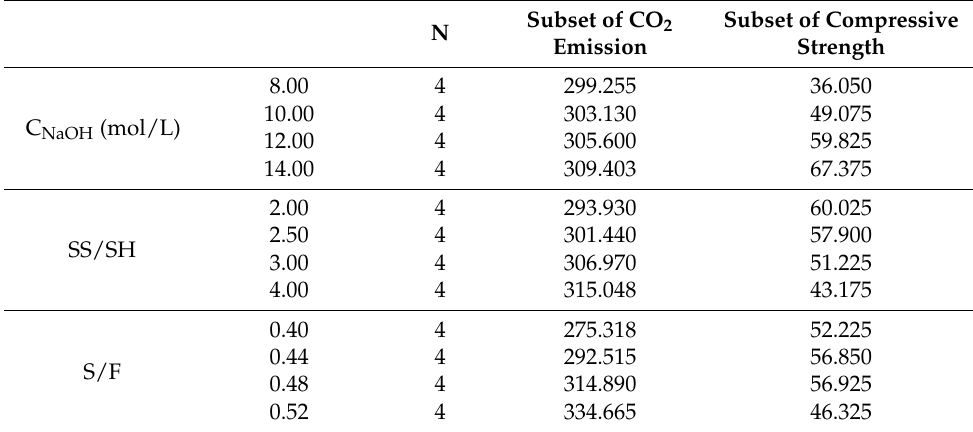
Table 7. Tukey–Kramer analysis simplified results on